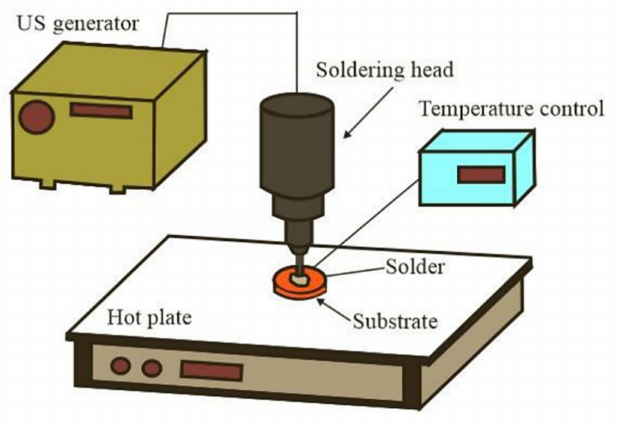
Figure 3. Set-up scheme for ultrasonic